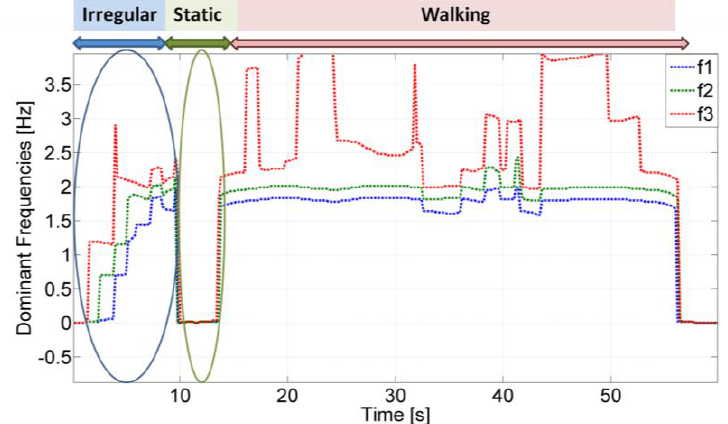
Figure 5. Dominant frequencies of the accelerometer signal over time. The IMU is carried in the user’s hand.